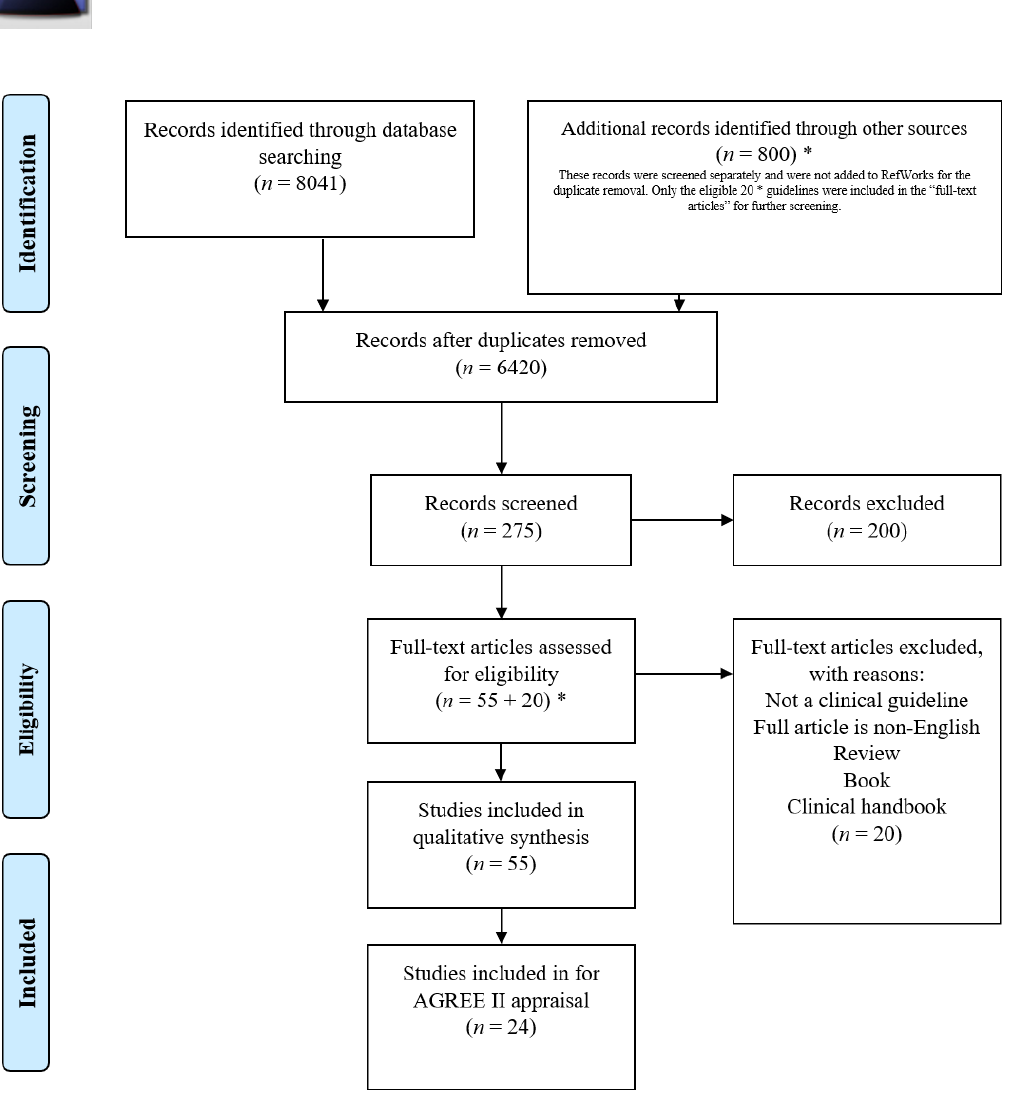
Figure 1. PRISMA 2009. Flow Diagram 1.